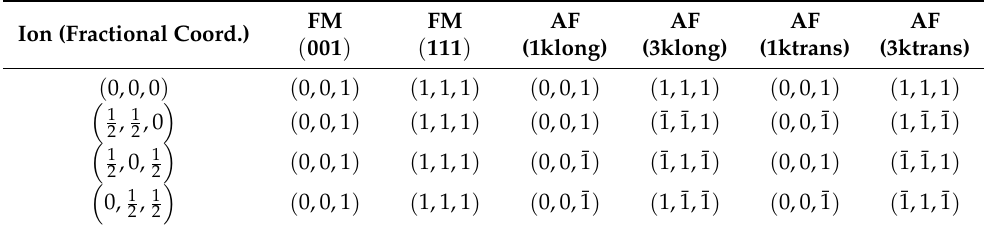
Table 1. Magnetic states investigated in this study. Parenthetical terms correspond to magnetic orderings defined in the